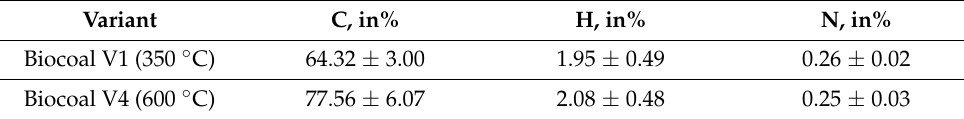
Table 3. Elemental analysis of the biocoals in % of the dry